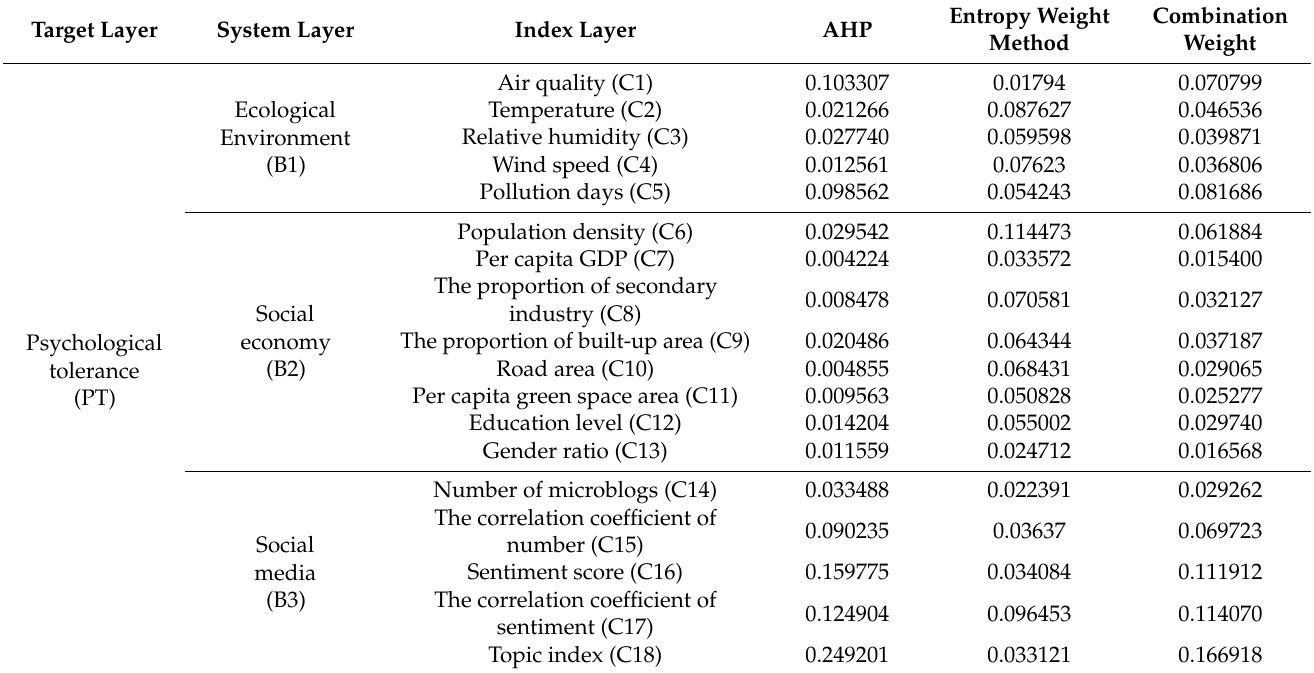
Table 10. Calculation results of the index weight.